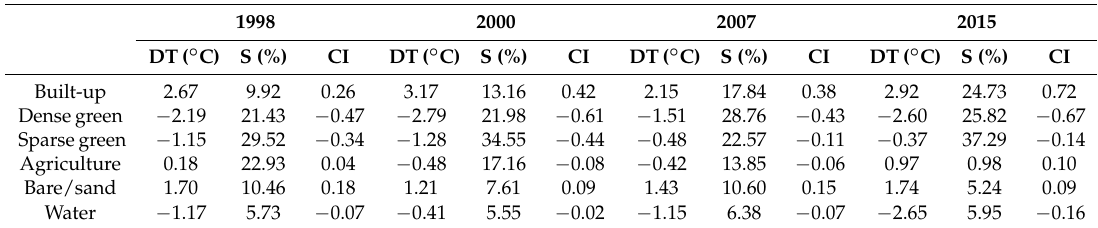
Figure 4. Land surface temperature change in Freetown ( A – D ) and Bo town ( E – H ) between 1998 and 2015. Table 3. Changes in the heat source/sink role of land use and land cover types in Freetown between 1998 and 2015. Green means